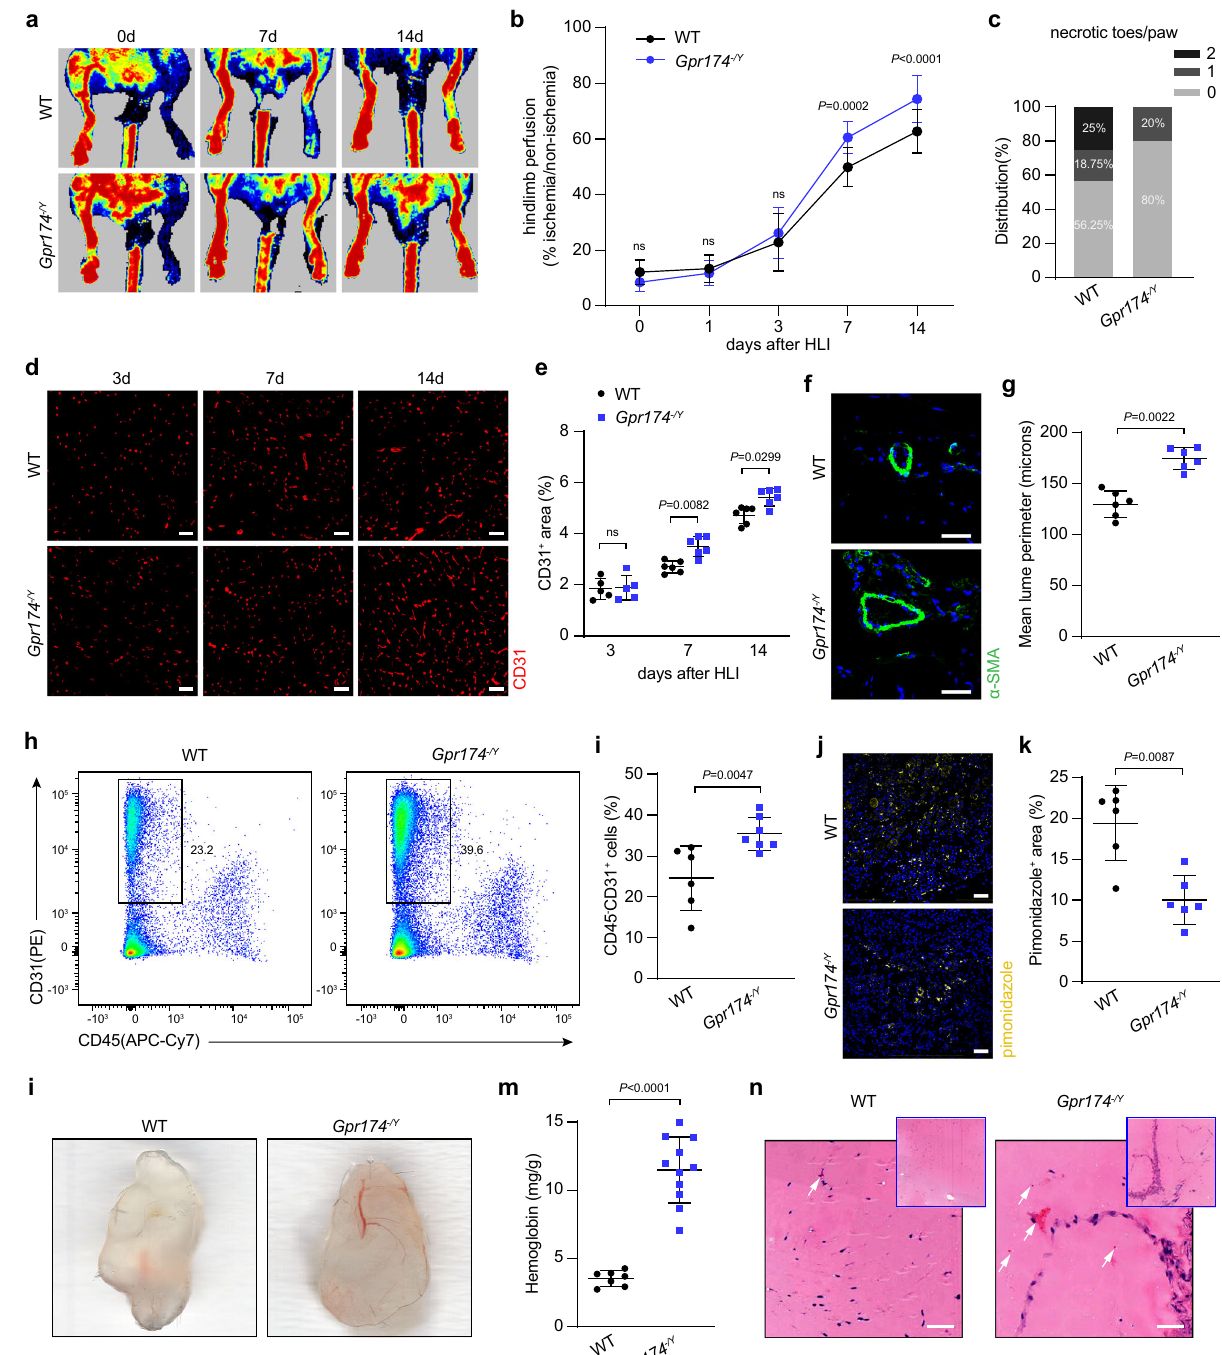
Fig. 1 | GPR174 de fi ciency improves blood fl ow recovery after HLI. a , b Representative images and quanti fi cation of hindlimb blood perfusion in WT and Gpr174 − /Y mice using Laser Doppler imaging at the indicated times after HLI ( n =16 for WT mice; n =15 for Gpr174 − /Y mice). c Distribution of necrotic toes per paw 14 days after HLI ( n =16 for WT mice; n =15 for Gpr174 − /Y mice). d , e Representativeimmuno fl uorescentimagesofCD31stainingandquanti fi cation of CD31 + area in WT and Gpr174 − /Y mice gastrocnemius cross sections at the indi- cated times afterHLI( n =5for WTand Gpr174 − /Y mice 3daysafterHLI; n =6 forWT and Gpr174 − /Y mice 7 and 14 days after HLI). Scale bar, 50 μ m. f , g Representative images of α SMA (green) and DAPI (blue) immunostainings and quanti fi cation of lumenperimeterinWTand Gpr174 − /Y miceadductorcrosssections14daysafterHLI ( n =6; wild-type: 50 arteries from 6 mice, Gpr174 − /Y : 51 arteries from 6 mice). Scale